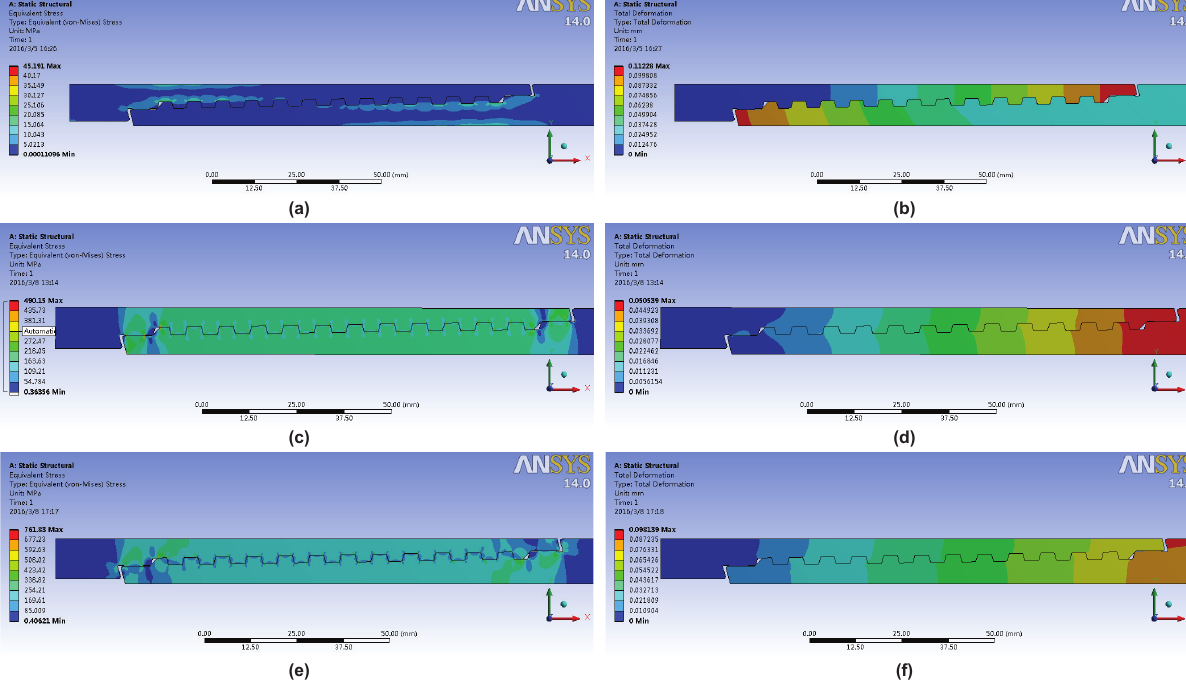
Figure 7. Joint stress and strain under allowable tensile force: (a) joint stress in state A , (b) joint strain in state A , (c) joint stress in state B ,